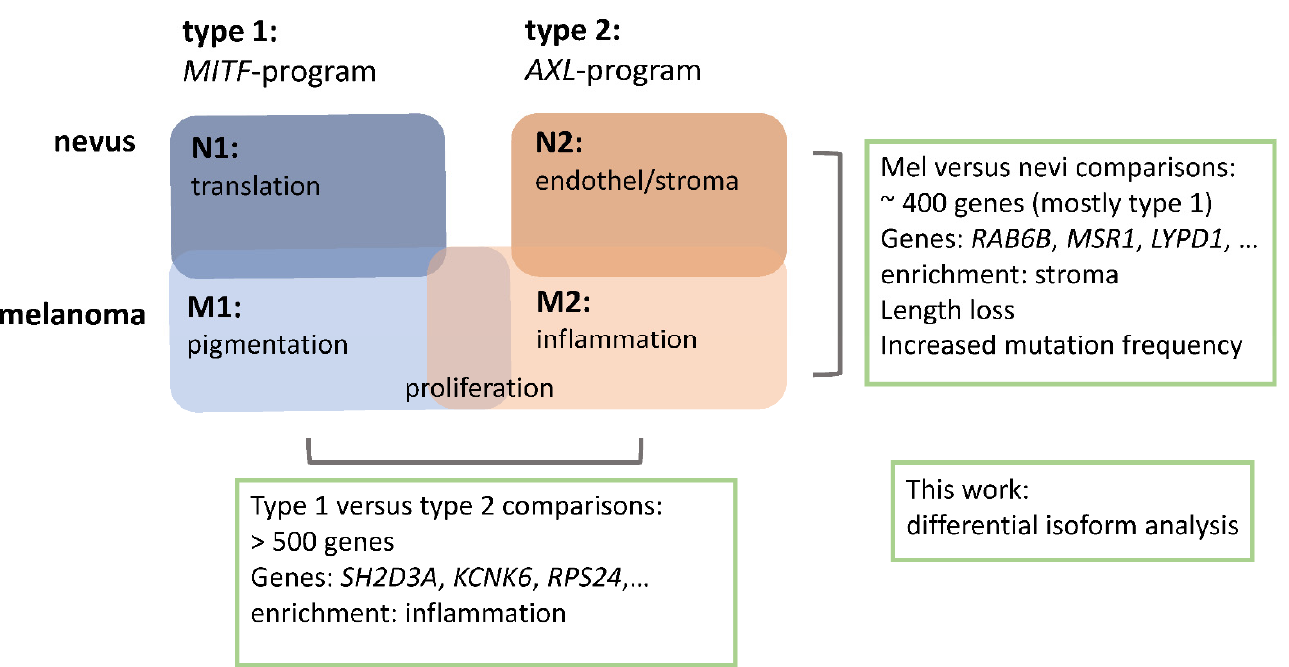
Figure 1. Stratification of the transcriptomes of benign nevi and melanomas into two types as described previously [11]. The functional context of the different subtypes is provided in the boxes. Isoform analyses performed in this work are noted in the boxes with green borders.